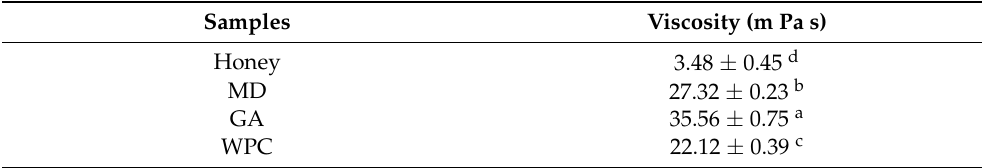
Table 2. Viscosity of honey and feed mixtures fortified with maltodextrin (MD), gum arabic (GA), and whey protein concentrate (WPC) carrier agents with aonla and basil